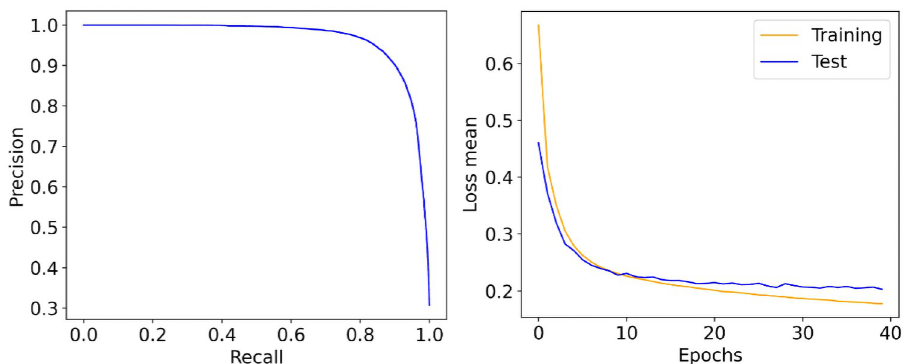
Fig 6. Performance of the selected deep CNN model based on the P-R curve (left) and cross-entropy loss function during the training and test stages (right).